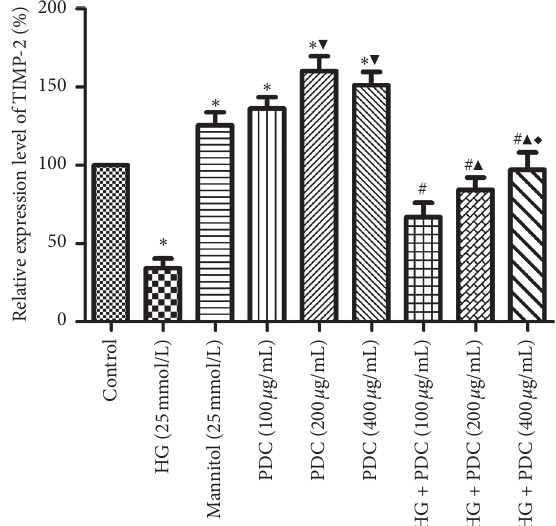
Figure 5: Effects of high glucose concentration and PDC on the mRNA expression of TIMP-2 in the HSF cells. HSF cells were incubated at high glucose concentration (25 mmol/L) or PDC (100, 200, and 400 μ g/mL) for 48 h. The total RNA of the cells was collected, and the mRNA expression of TIMP-2 in the cells was detected by real-time quantitative PCR. All the data were expressed as x ± S ( n � 3). ∗ P < 0 . 05, compared with the control group; ▼ P < 0 . 05, compared with the Dendrobium polysaccharide (100 μ g/mL) group; # P < 0 . 05, compared with the high-glucose group; ▲ P < 0 . 05, compared with the high-glucose + Dendrobium polysaccharide (100 μ g/mL) group; ◆ P < 0 . 05, compared with the high-glucose + Dendrobium polysaccharide (200 μ g/mL)